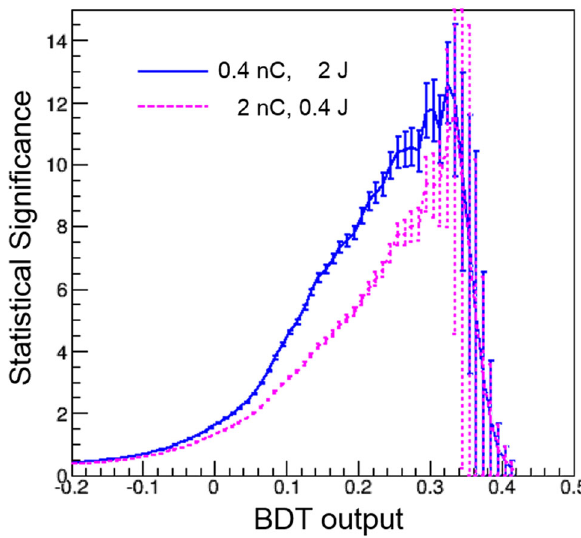
Fig. 9 Expected statistical significance of γγ → γγ signal over the background after 1 year of operation for the operating conditions of (0.4 nC, 2 J) (blue-solid), and (2 nC, 0.4 J) (purple-dashed)